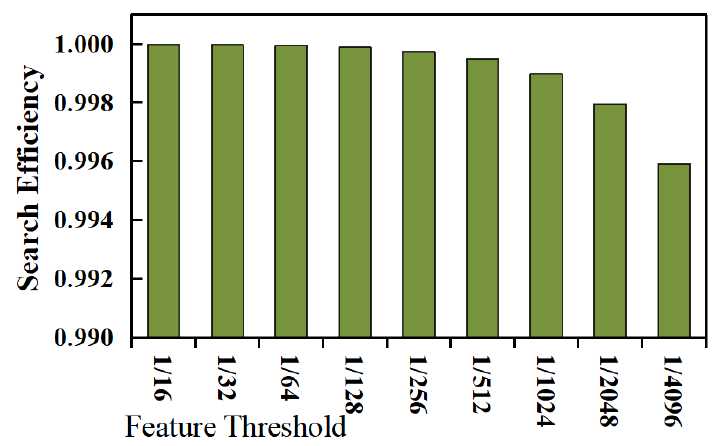
Figure 6. Evaluation result for textual data implication query efficiency.